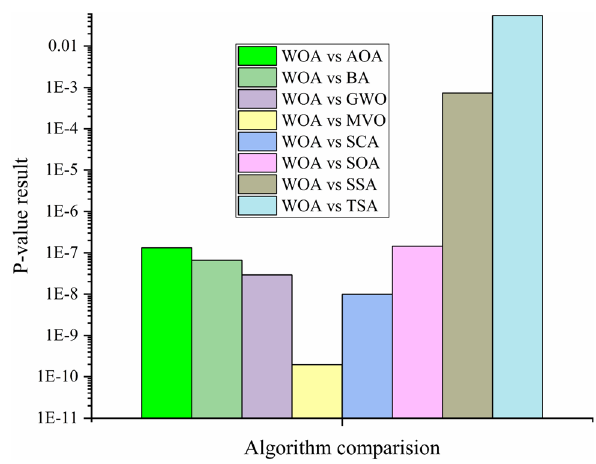
Fig. 15 The p-value test of the algorithms for case 1